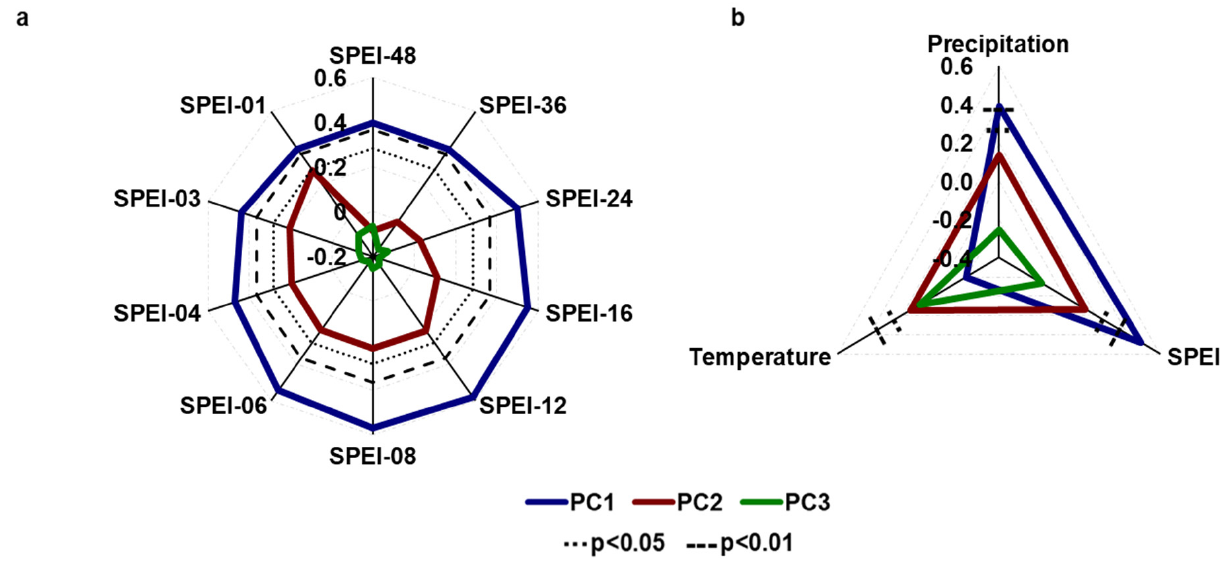
Figure 7. Comparison of relationships between the principal components (i.e., PC1, PC2, and PC3)